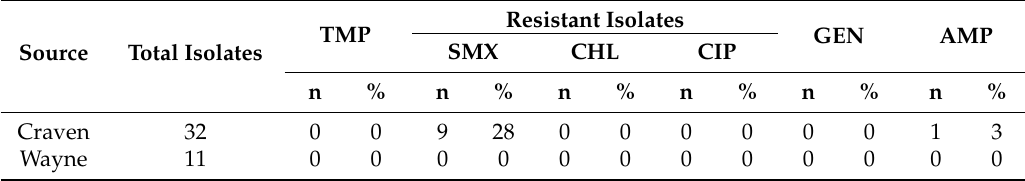
Table 2. Antimicrobial resistance in Salmonella isolates from surface water.